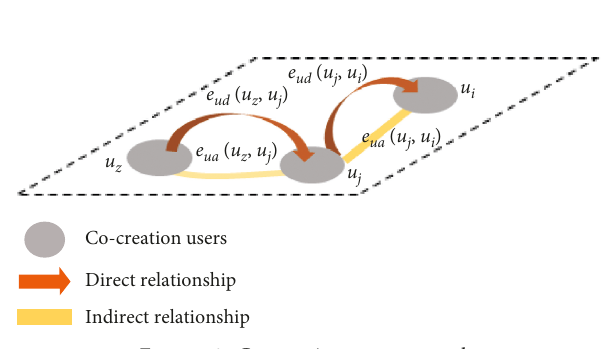
Figure 2: Co-creation user network.